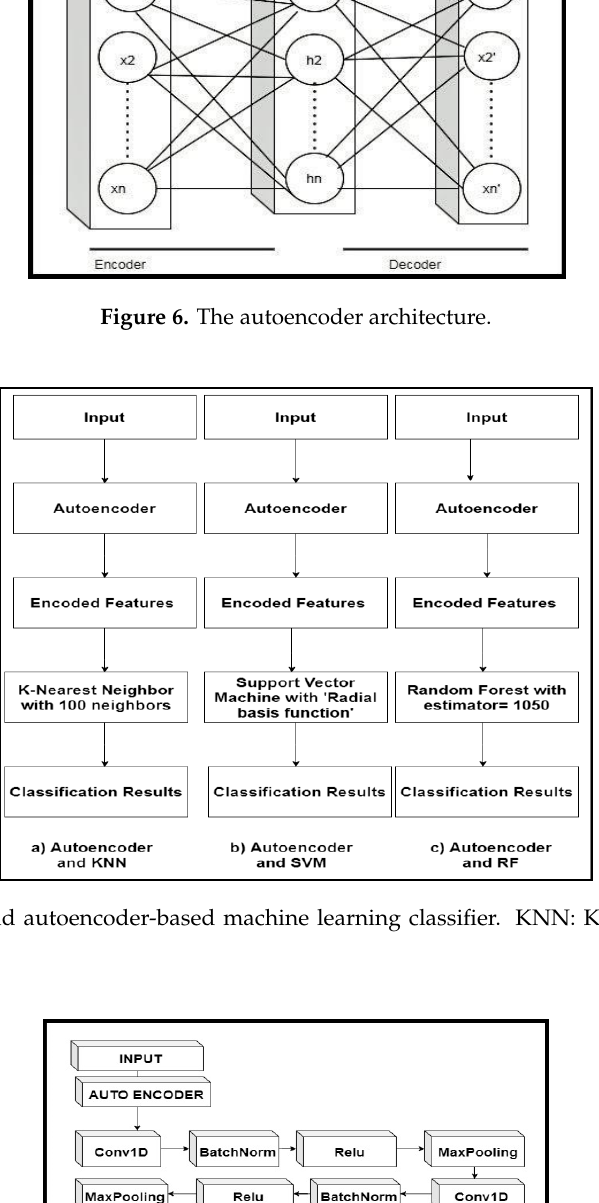
Figure 8. The hybrid model of an autoencoder and convolutional neural network (CNN). 5. Experiment Results The Google Colaboratory (Colab) was used to perform experiments, a free online cloud-based Jupyter notebook that allowed us to train our machine learning and deep learning models on CPUs, GPUs, and TPUs. The ABIDE-I dataset has rs-fMRI data for 1112 candidates, along with phenotypic information. This data is slice time corrected, motion-corrected, and normalized. In our study, all rs- fMRI data were from the CPAC preprocessing pipeline and band-pass filtered (0.01–0.1 Hz). From these 1112 subjects, 1035 subjects were considered for our study since only these subjects had completed phenotypic information. To limit the variance between outputs to just preprocessing, statistical derivatives for each pipeline and strategy were calculated using the CPAC software [8]. The rs-fMRI (shown in Figure 9) stands for resting-state fMRI, a type of functional magnetic resonance imaging (fMRI) used in brain mapping to evaluate regional interactions in a resting or task-negative state when an explicit task is not performed. The resting-state process helps explore the